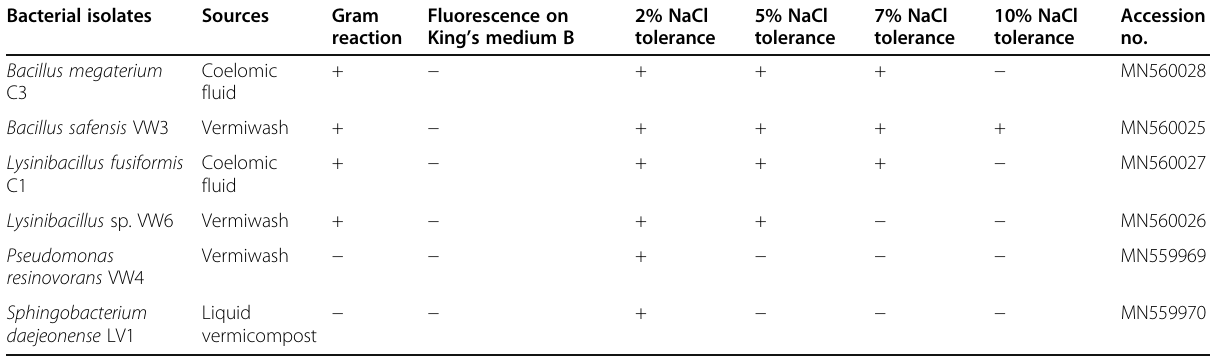
Table 4 The bacterial isolates from liquid vermicompost, vermiwash, or the coelomic fluid of earthworm, and their accession numbers of their 16S rDNA sequences deposited in the GenBank database Bacterial